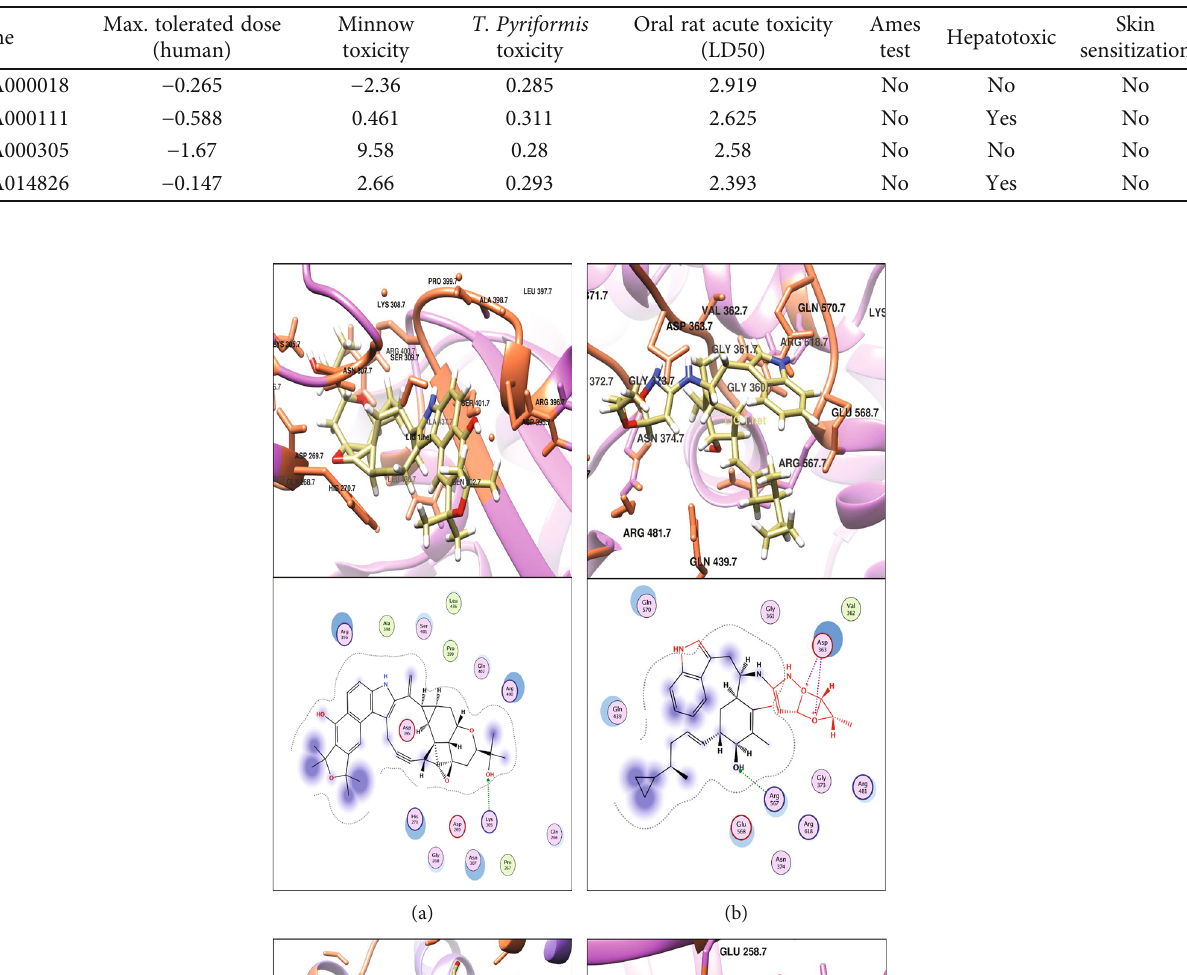
Table 3: Toxicity analysis of the shortlisted four